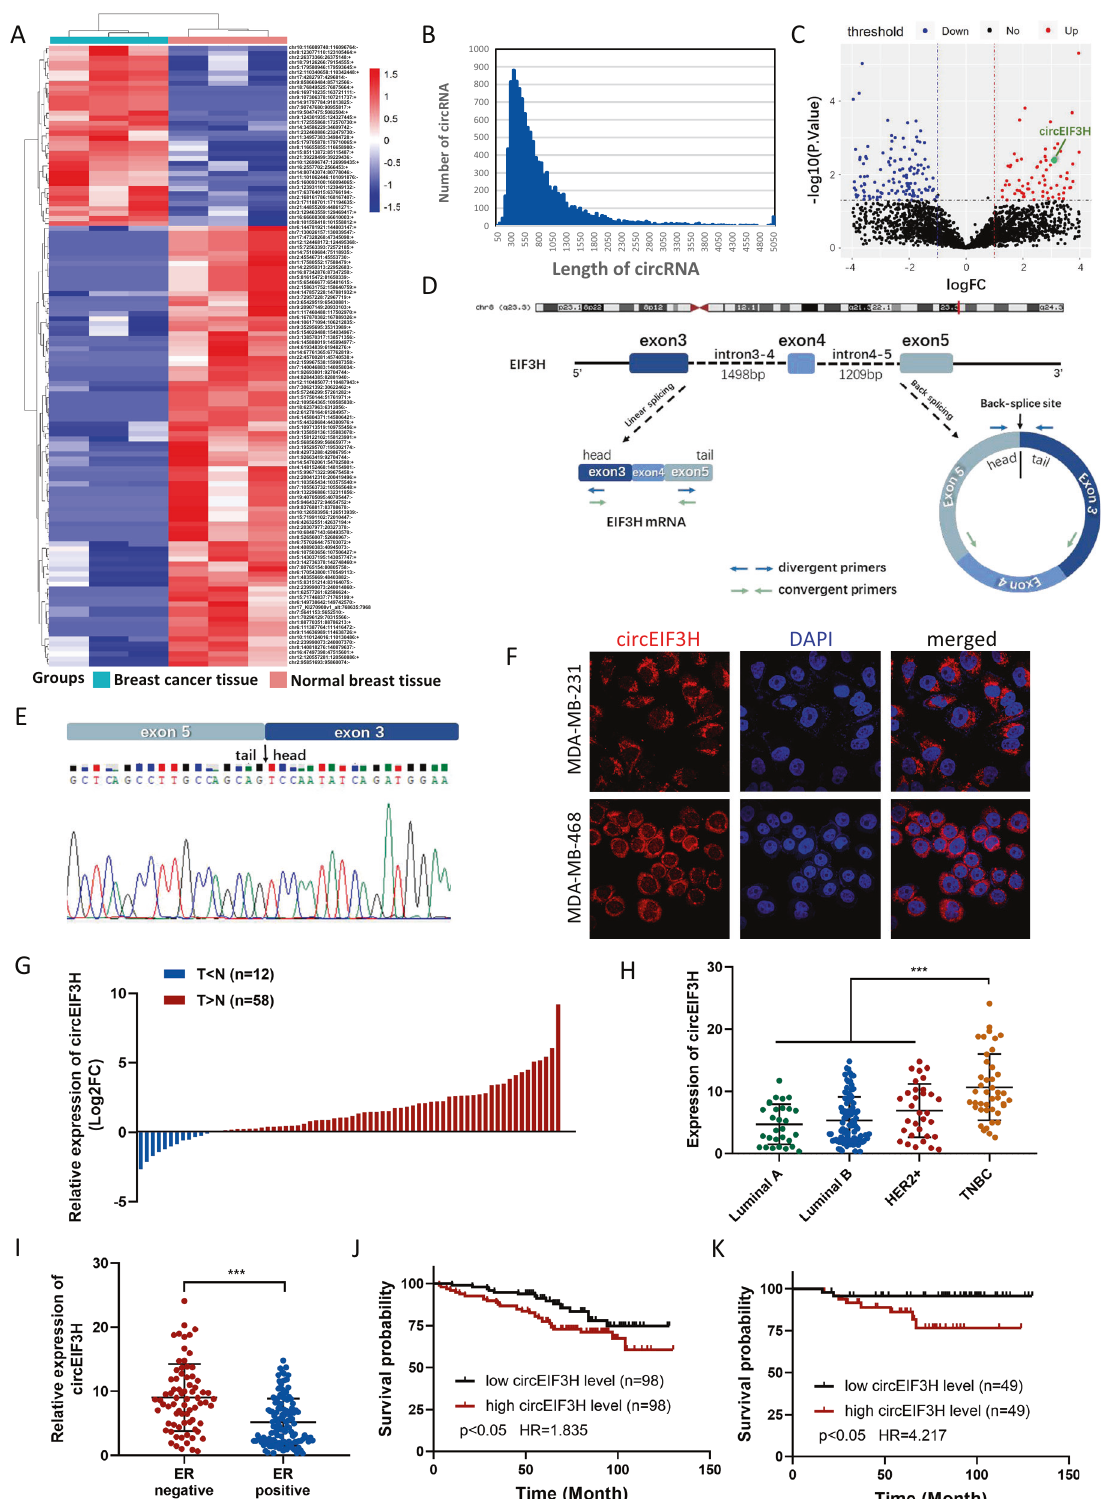
Fig. 1 CircEIF3H is upregulated in breast cancer tissues and associated with poor prognosis. A Heat maps showing the top differentially expressed circRNAs in three breast cancer samples compared to their adjacent normal tissues. B Length distribution of identi fi ed circRNAs in three paired breast cancer tissues and adjacent normal tissues. C Volcano plots showing the expression pro fi les of circRNAs. D Schematic illustrations showed the genomic loci of circEIF3H. circEIF3H was produced by exons 3 to 5 of the EIF3H gene. E Back-splice junction of circEIF3H identi fi ed by Sanger sequencing. F RNA fl uorescence in situ hybridization for circEIF3H. Nuclei were stained with DAPI. G The expression level of circEIF3H in 70 pairs of breast cancer tissues and adjacent normal breast tissues. The bar chart presented the log 2 FC. H , I Expression level of circEIF3H in a different subtype of breast cancer. J , K Kaplan – Meier analysis showed the association between circEIF3H expression and overall survival of breast cancer patients ( n = 196) ( J ) or TNBC patients ( n = 98) ( K